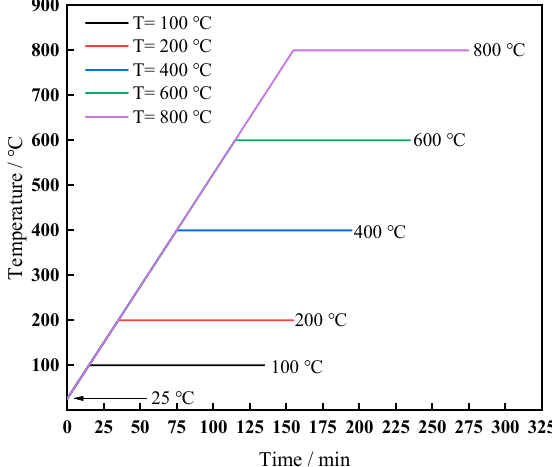
Figure 3. Temperature rise curve of different temperature groups.